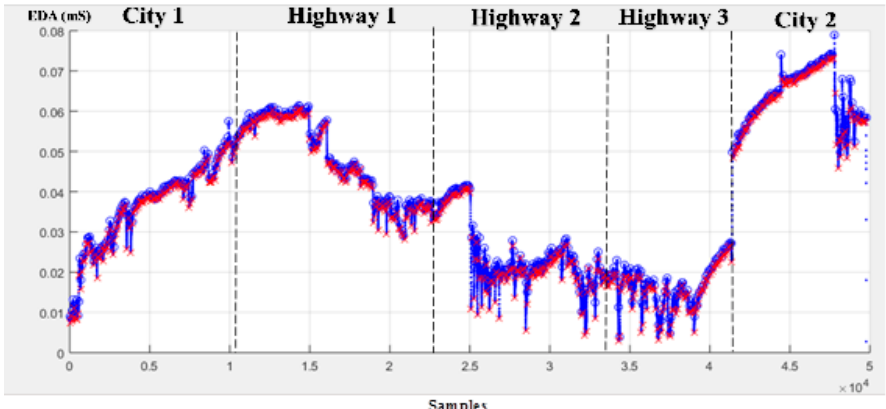
Figure 4. EDA signal processing for January 11, 2018 morning session (peaks and valleys are marked by ○ and ×, respectively).